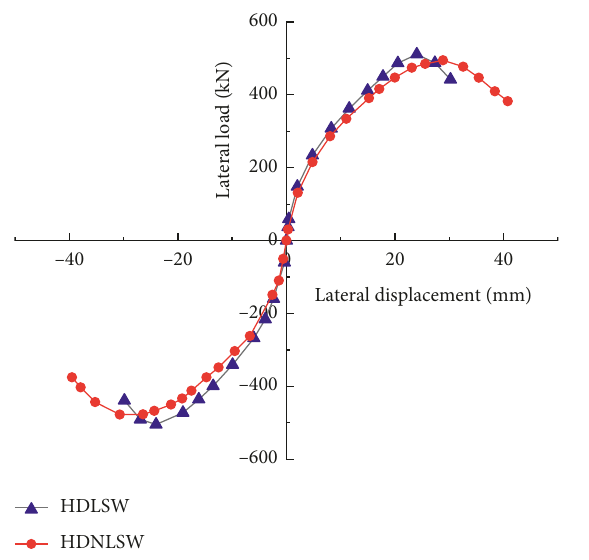
Figure 12: Equivalent viscous damping ratios of two